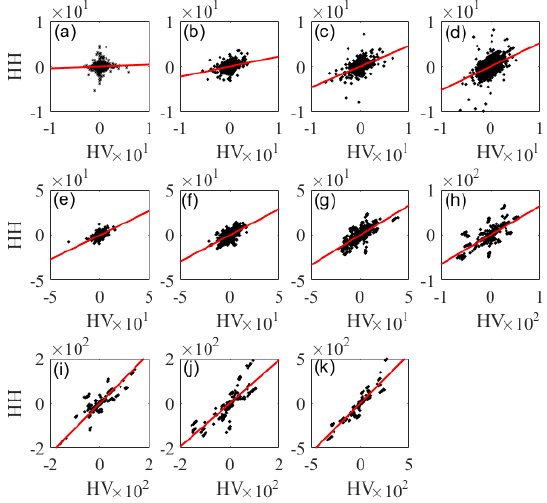
Figure 13. Scatter plots (HV vs. HH) of the wavelet coefficients in the vertical direction ( a – k indicates the wavelet decomposition scales ranging from 1 to 11).